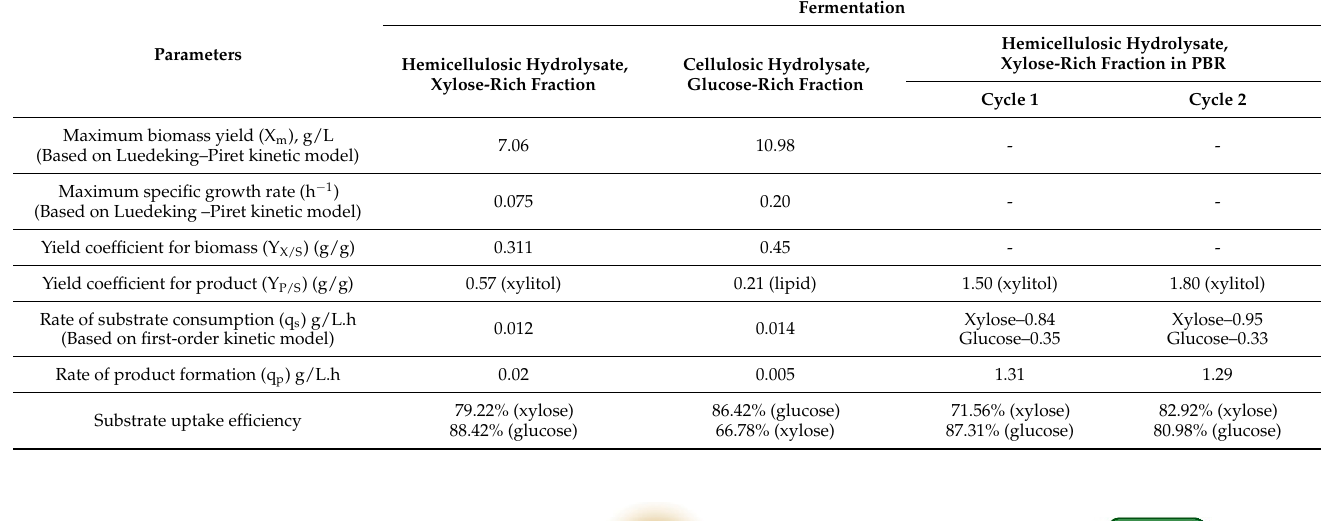
Table 4. Kinetic parameters of different fermentations.